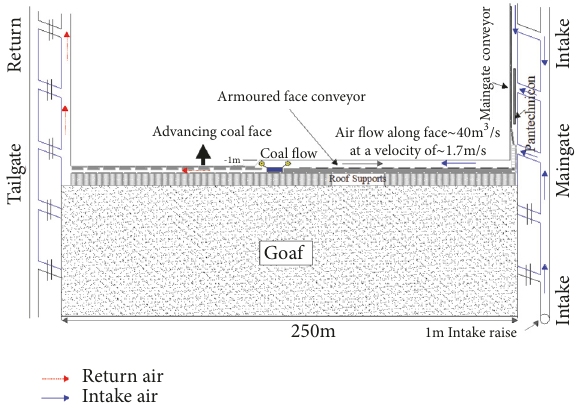
Figure 9: Conventional (antitropal face and belt airflow) ventilation system.